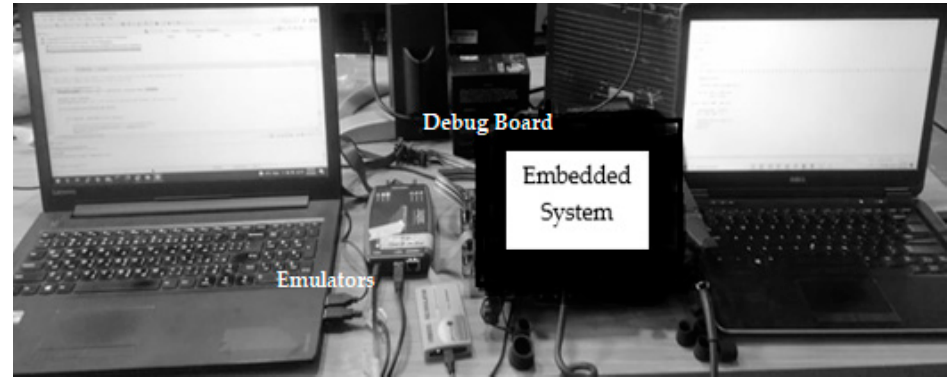
Figure 6. Emulator environment where two emulators connected with two PEs.